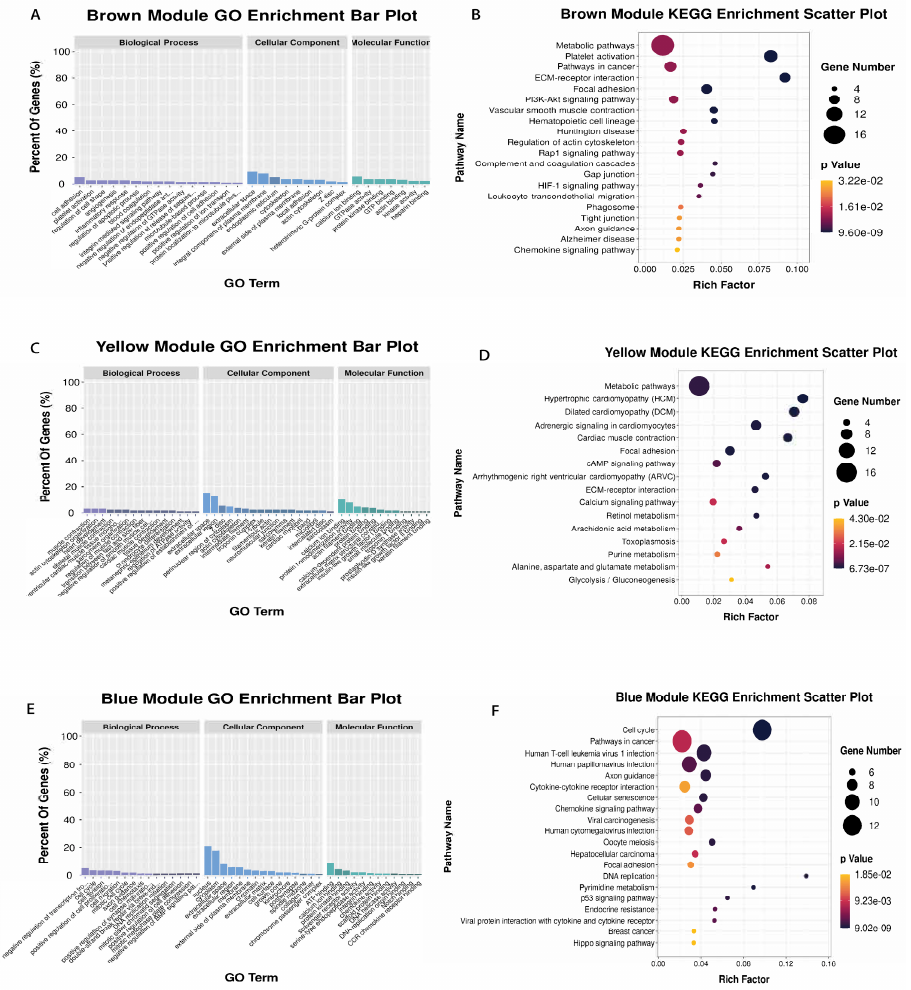
Figure 4. Results of GO analysis and KEGG enrichment in related specific module genes. ( A ) GO enrichment results of genes in brown module. ( B ) KEGG results of genes in brown module. ( C ) GO enrichment results of genes in yellow module. ( D ) KEGG results of genes in yellow module. ( E ) GO enrichment results of genes in blue module. ( F ) KEGG results of genes in blue module.